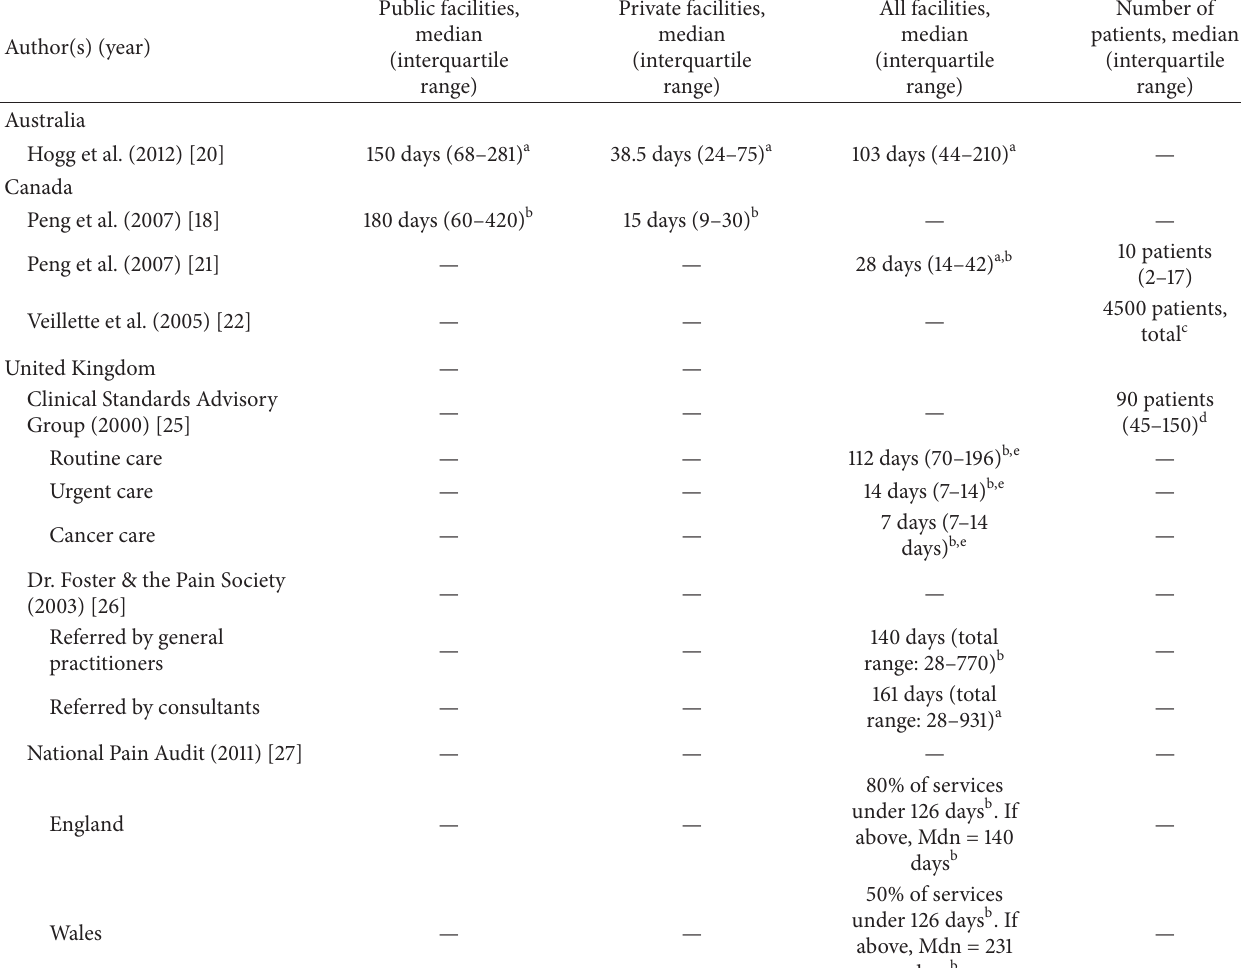
Table 3: Pain treatment facility wait times and number of patients waiting for